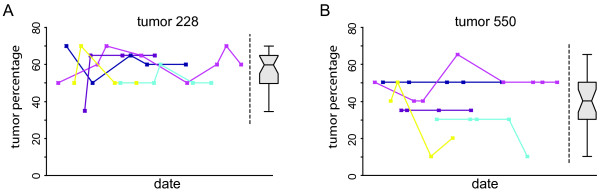
Variation in histo-pathological tumour percentage scoring. An identical H/E stained tumour section of two tumours (A, T228 and B, T550) was scored multiple times by five different pathologists (coloured lines) during a period of 6 months. Box-plots represent the overall pathological variation in TCP scoring for each of the two tumour samples.